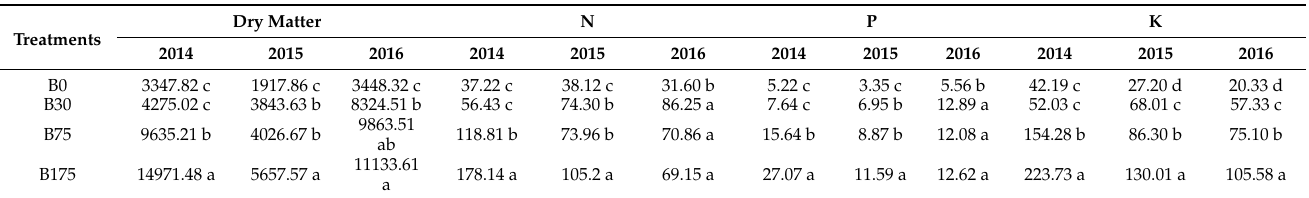
Table 5. Above-ground maize dry matter and N, P, and K uptakes in sulfate saline soils amended with biochar at various rates from 2014 to 2016 (kg hm − 2